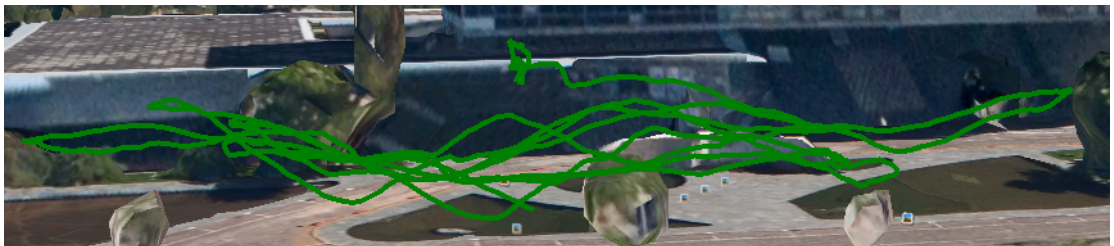
Figure 14. Manual flight path with vertical zig-zag